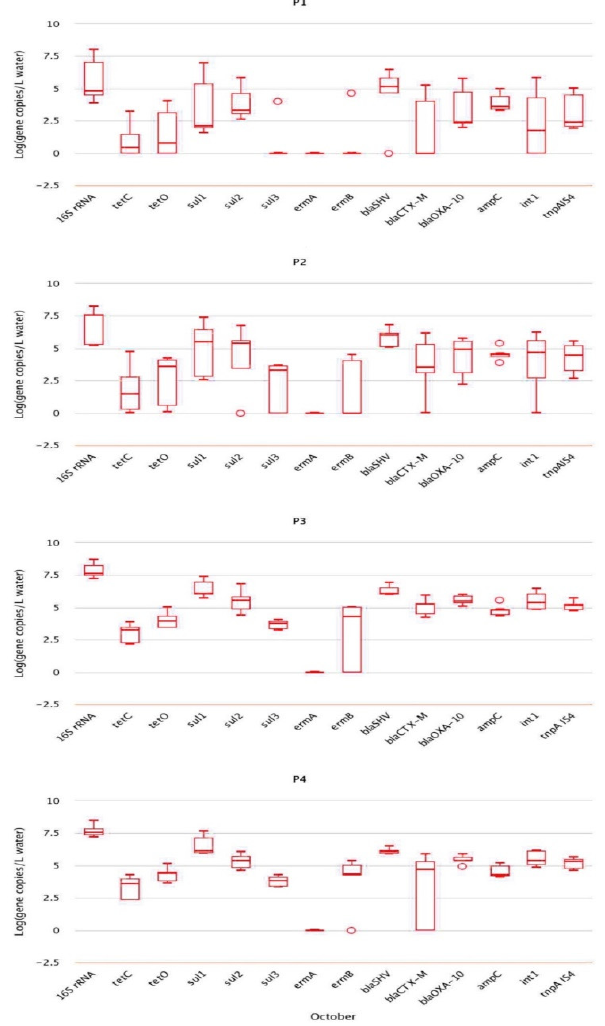
Figure 2. Abundance of resistance genes in samples collected in October.